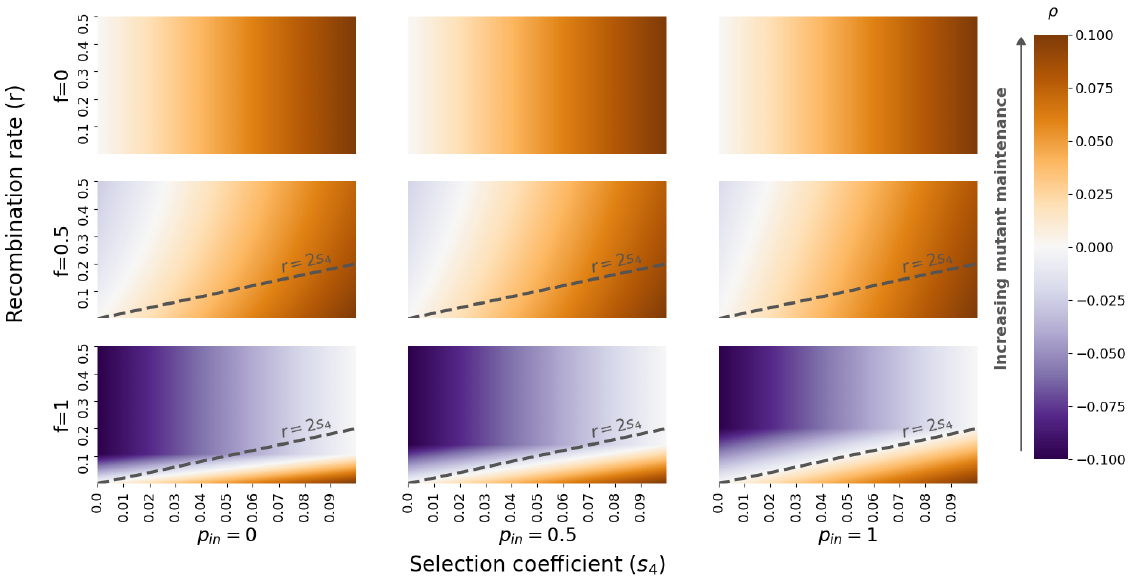
Figure 2 – Dominant eigenvalue ρ for the overdominance scenario. When ρ ≤ 0 (blue areas), the mutation is purged with probability 1. When ρ > 0 (red areas), the mutation has a non-zero probability to escape purging. The mutation is maintained longer in the population as ρ increases. All panels have the same axes. x-axis: s 4 , selection coefficient for wild-type BB homozygotes. y-axis: r , recombination rate between the two loci. Each column corresponds to a value of p in (intra-tetrad rate, 0, 0.5, 1 ), and each row to a value of f (selfing rate, 0, 0.5, 1 ). The selection coefficient for bb homozygotes is set to s 3 = 0.1 . The line r = 2 s 4 is displayed for comparison with the findings in Antonovics and Abrams,